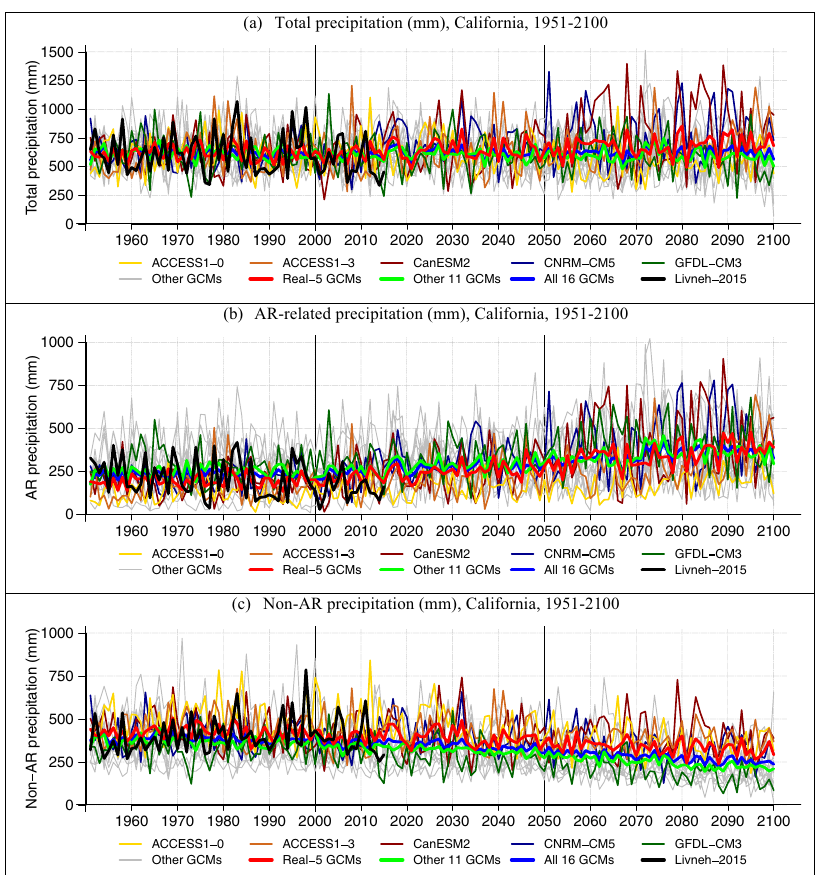
Figure 4. Annual total ( a ), AR-related ( b ) and non-AR related ( c ) LOCA-downscaled precipitation spatially averaged over California during historical (1951–2005, left) and projected (2007–2100, right) time periods. Results from the Real-5 GCMs are plotted in thin colored lines, while the Other GCMs are outlined in gray. Thick curves represent the ensemble averages of the Real-5 GCMs (red), the Other 11 GCMs (green) and the full ensemble of 16 GCMs (blue). Thick black curve delineates the annual total ( a ), AR-related ( b ) and non-AR ( c ) precipitation, which is based on observed precipitation data. Trends and their significance are quantified in Table